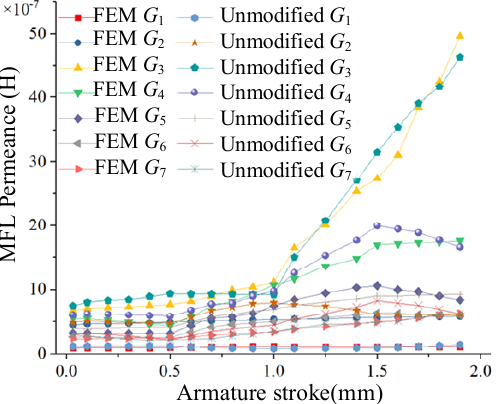
Figure 1. Solenoid valve with fan-shaped permanent magnet (PM): ( a ) sectional view of solenoid valve; ( b ) magnetic flux tube diagram (half of Figure 1a). The solenoid valve is excited in 0 AT, and its finite element method (FEM) responses are compared with the unmodified DPM, as shown in Figure 2. There are 20 sample points for every curve.